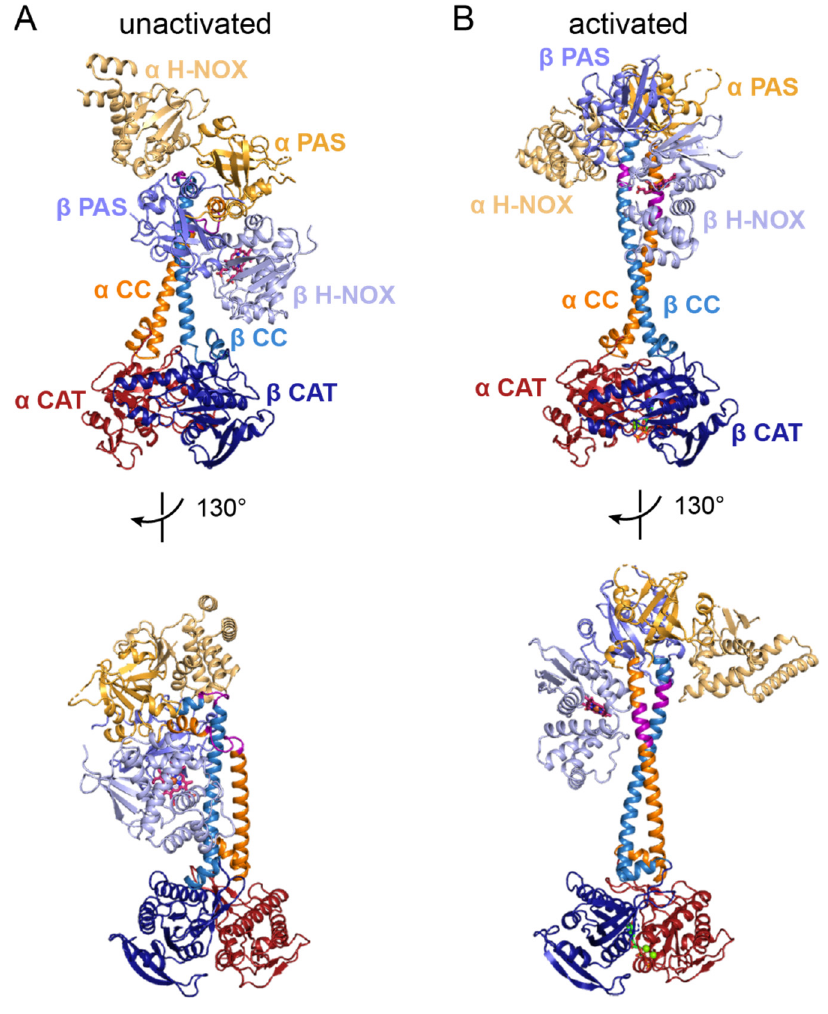
Figure 4. Activation of sGC induces a large-scale conformational change involving straightening of the CC domains. ( A ) Views of the unactivated conformation of sGC (PDB ID 6JT0 [65]). ( B ) Views of the activated conformation of sGC (PDB ID 6JT2 [65]). Protein is shown in ribbon representation with domains colored as indicated on the figure. The regions of the CC domains that bend and straighten are colored purple. The heme cofactor in the β H-NOX domain is shown in sticks with C in pink, N in blue, O in red, and Fe in orange.